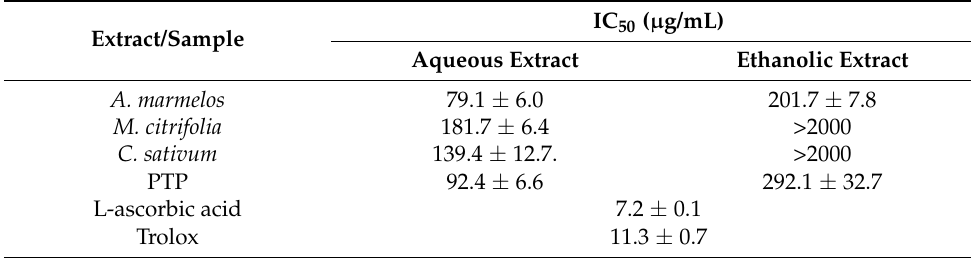
Table 2. DPPH radical scavenging of A. marmelos , M. citrifolia , C. sativum and PTP extracts from aqueous and ethanol